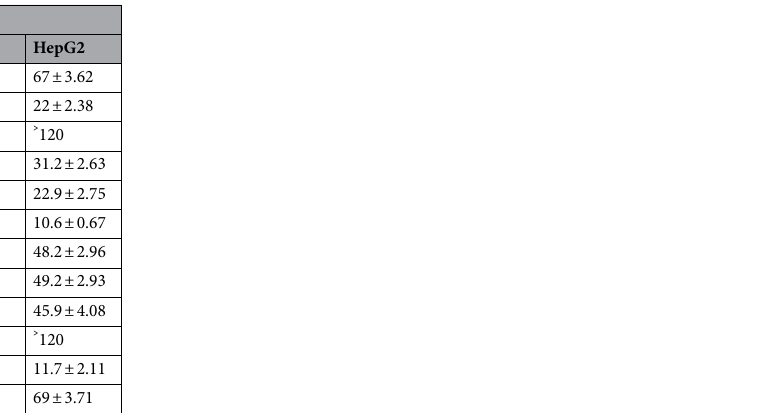
Figure 6. Proposed mechanism.